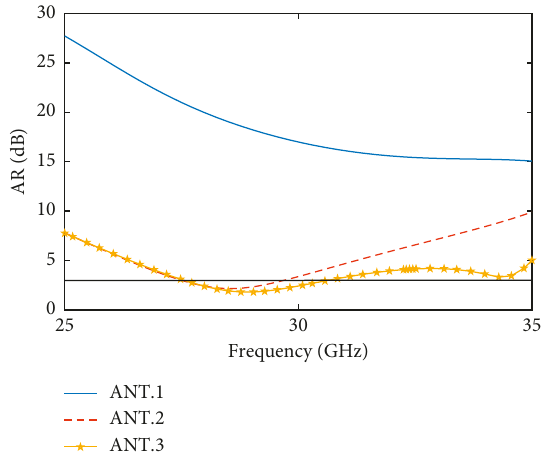
for ANT.1, ANT.2, and ANT.3. 11